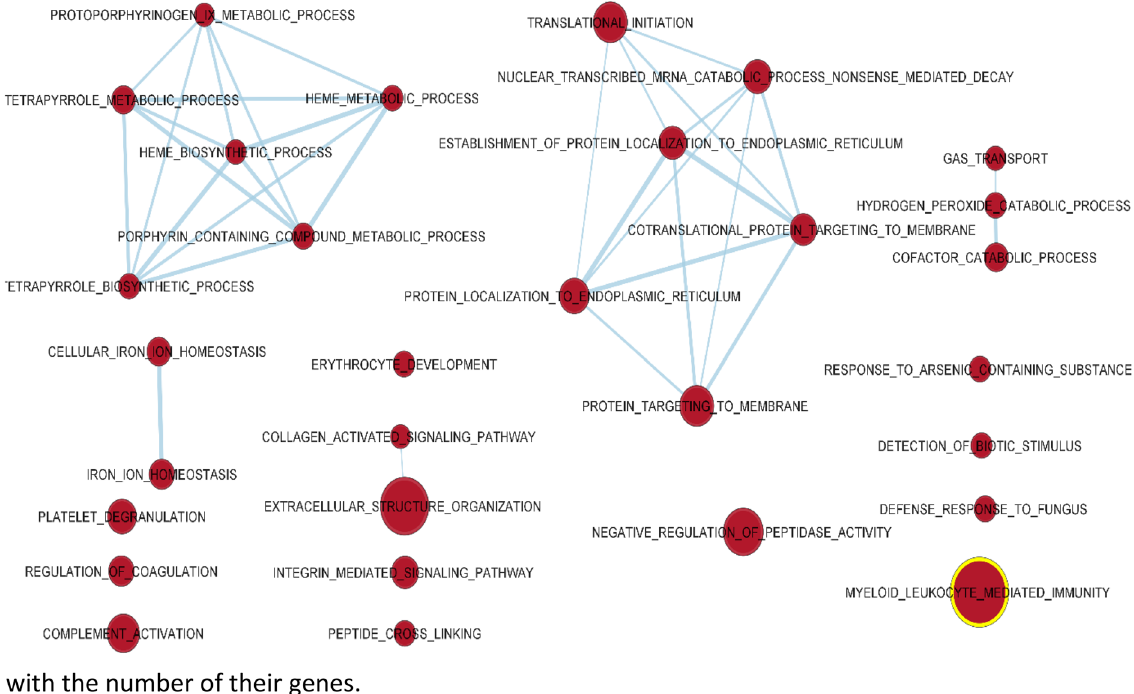
Figure 4. Gene sets upregulated in the peripheral blood of pigs on the day of weaning as compared to those sampled in pigs at 12 days post-weaning. The sets are enriched with FDR < 0.01. The edges represent the link of two or more gene sets sharing the same core group of genes, explaining the enrichment of each of the gene sets. Node colour intensity conveys enrichment significance (P-value) while their dimension increases with the number of their genes.